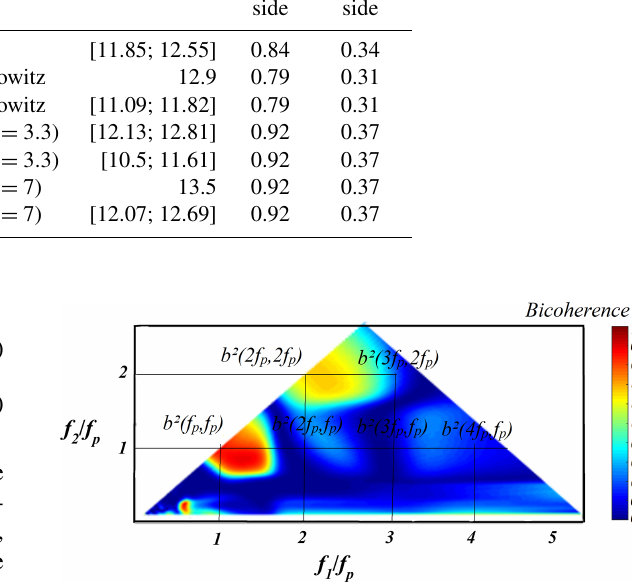
Figure 2. The wavelet-based bicoherence of a narrow-banded Gaus- sian wave train (Test 1) at x = 4m.